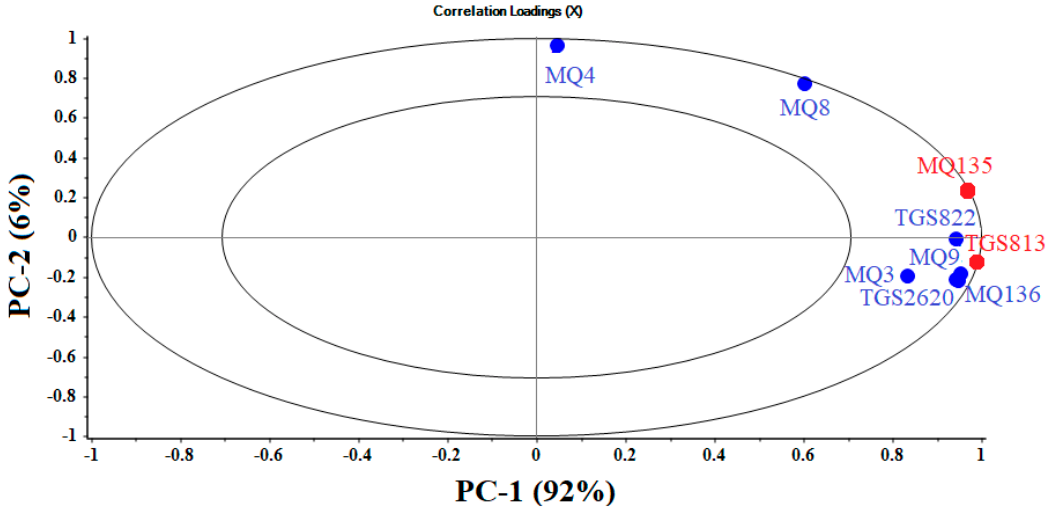
Figure 4. Loading plot for 2-dimensional PCA analysis showing essential oils e-nose data-clustering distribution with associated principal components.